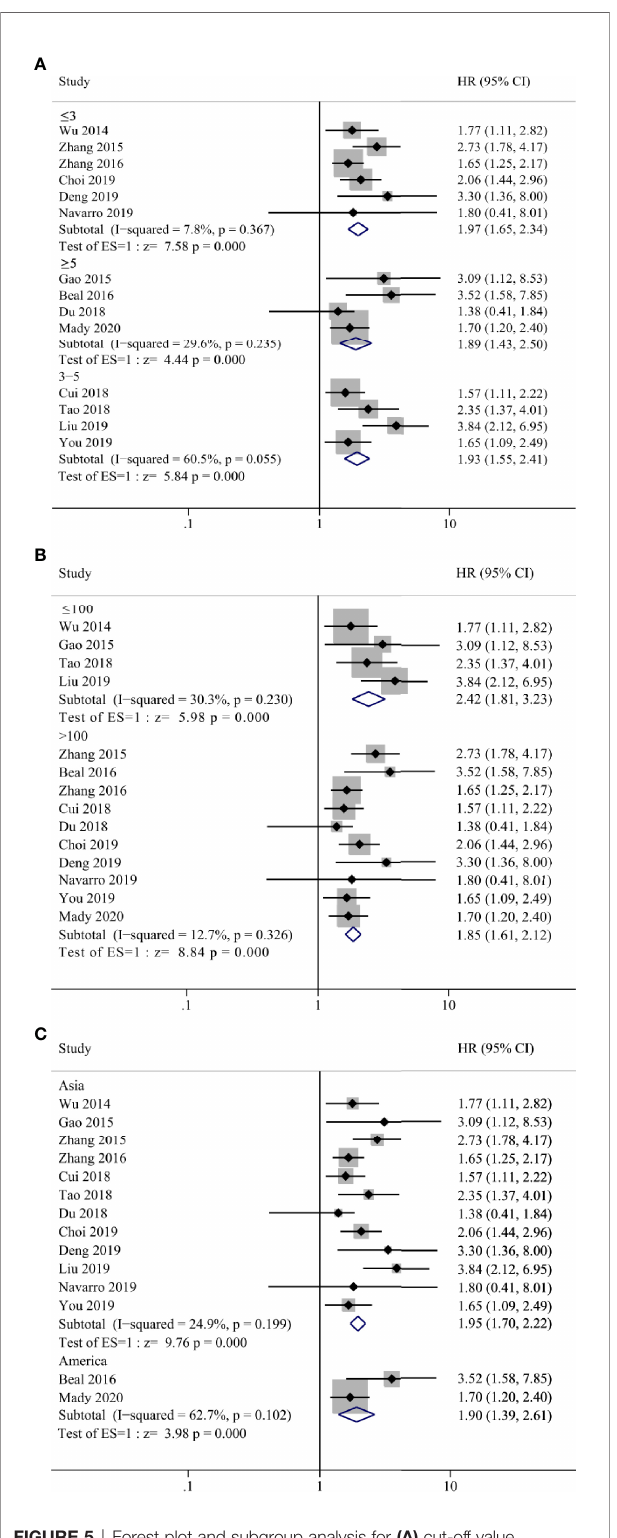
( Table 1 ). The receiver operating characteristic (ROC) curve